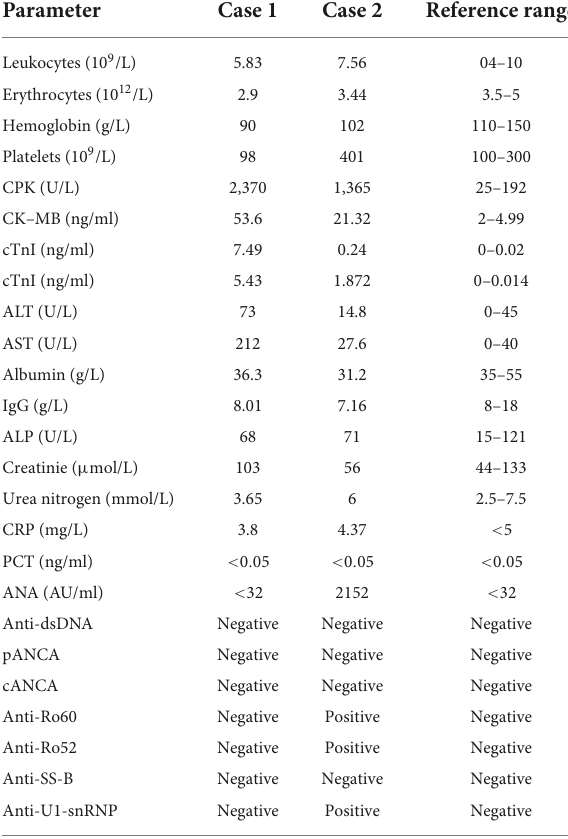
TABLE 1 Laboratory findings on